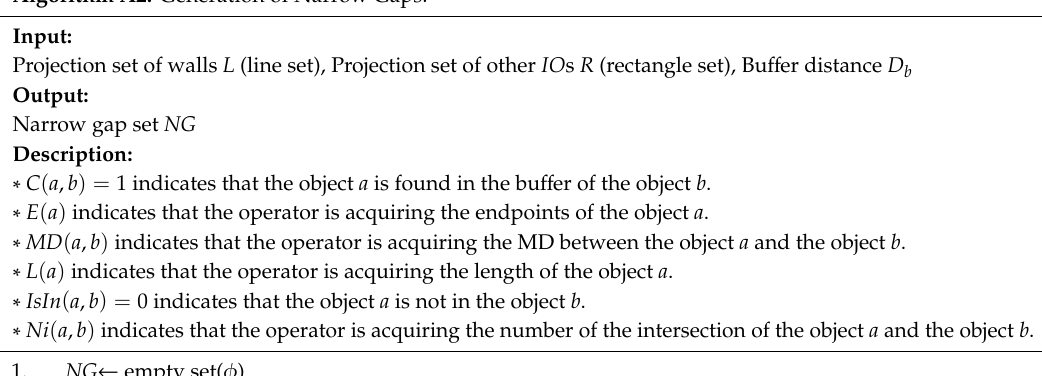
Algorithm A2: Generation of Narrow